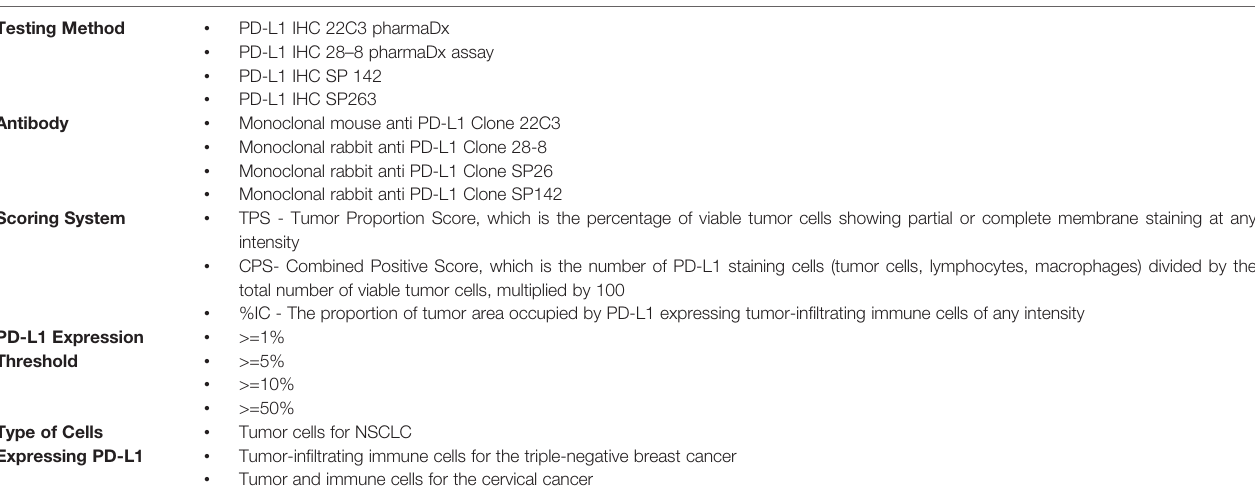
TABLE 1 | Variables for FDA Approved PD-L1